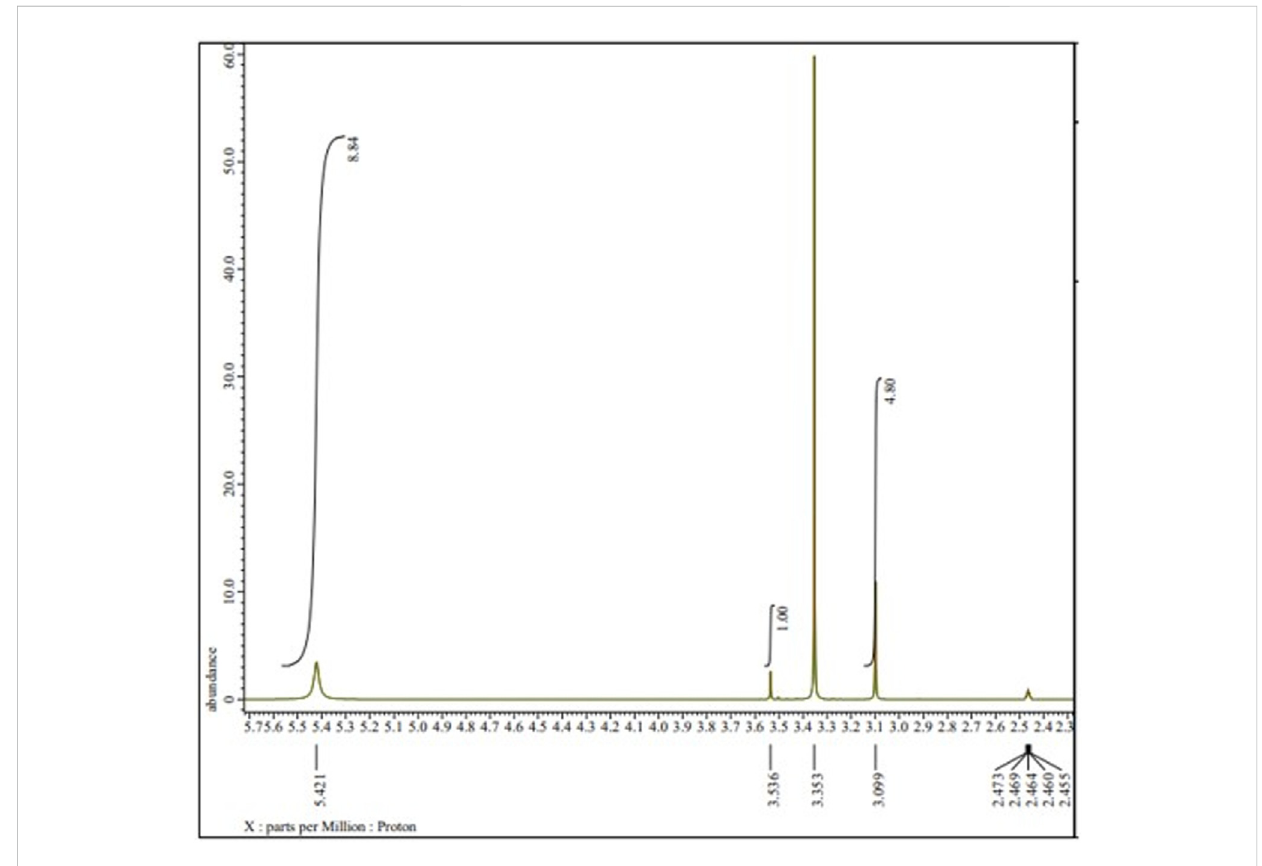
FIGURE 8 1 H-NMR of rosmarinic acid in